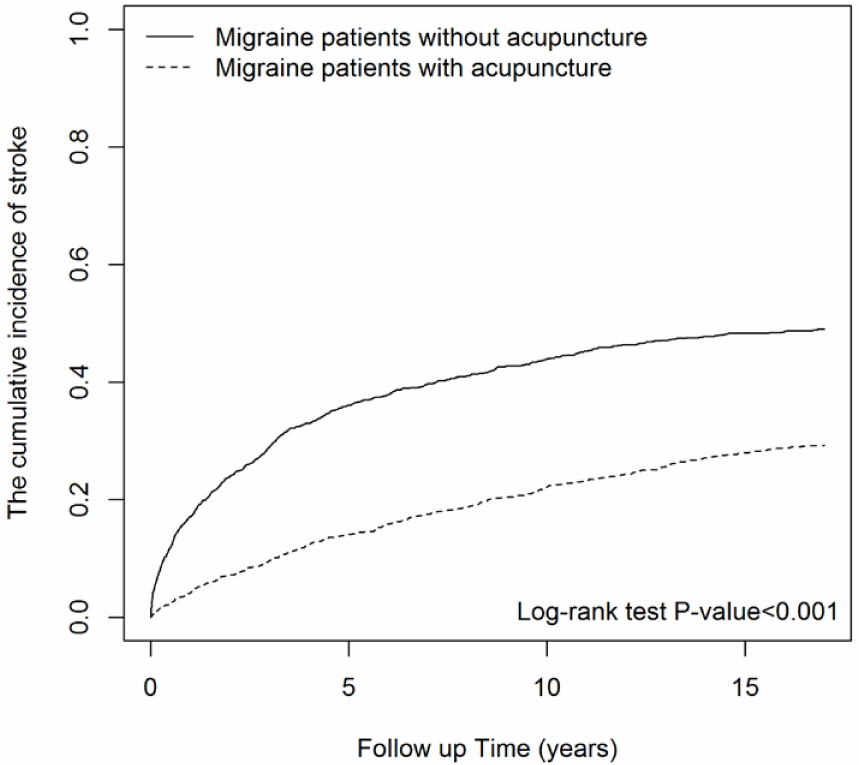
Figure 2. Cumulative incidence of strokes in the acupuncture and non-acupuncture